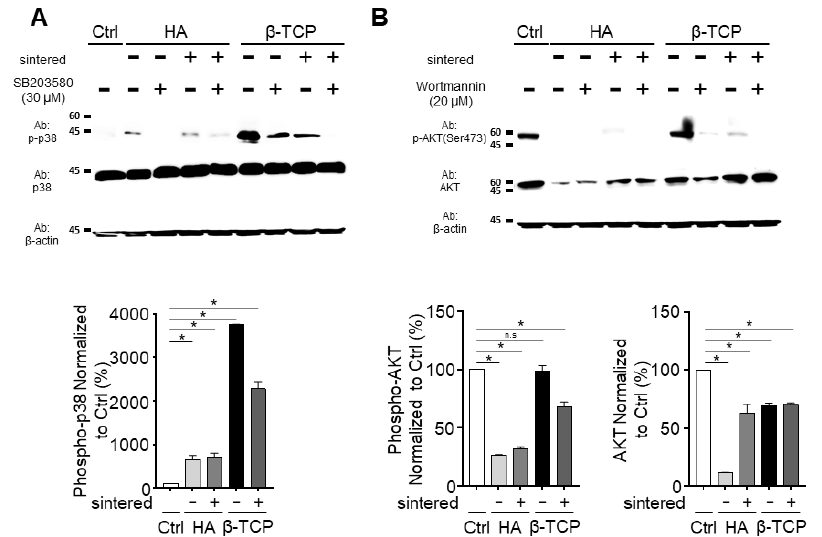
Figure 4. Western blotting measurements examining the p38 and AKT pathways of MG63 cells after exposure to the sintered and non-sintered bioceramics: ( A ) p38/p-p38; ( B ) AKT/p-AKT. The bar graphs show values presented as the mean ± the SEM., which have been normalized to the control samples in each case. The results were compared using the one-way ANOVA method. * p < 0.05; n.s = not significant.